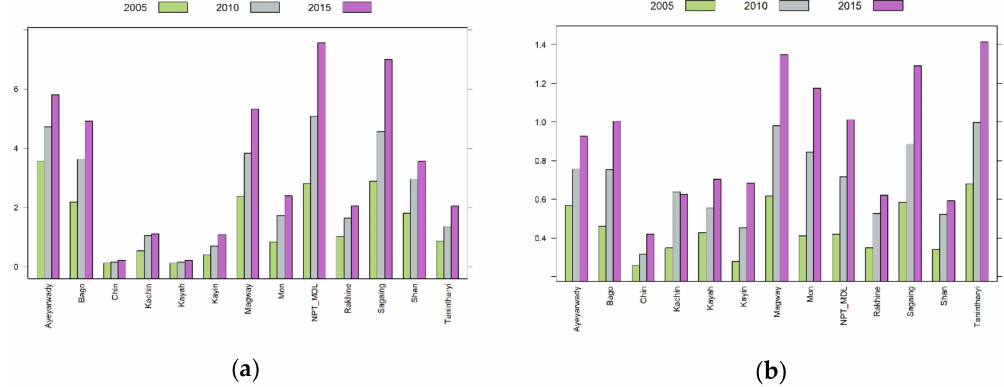
Figure 2. Bar plot: ( a ) Gross domestic product (GDP) by states and region (unit: 10 12 Kyats). ( b ) Per capita GDP by state and region (unit: million